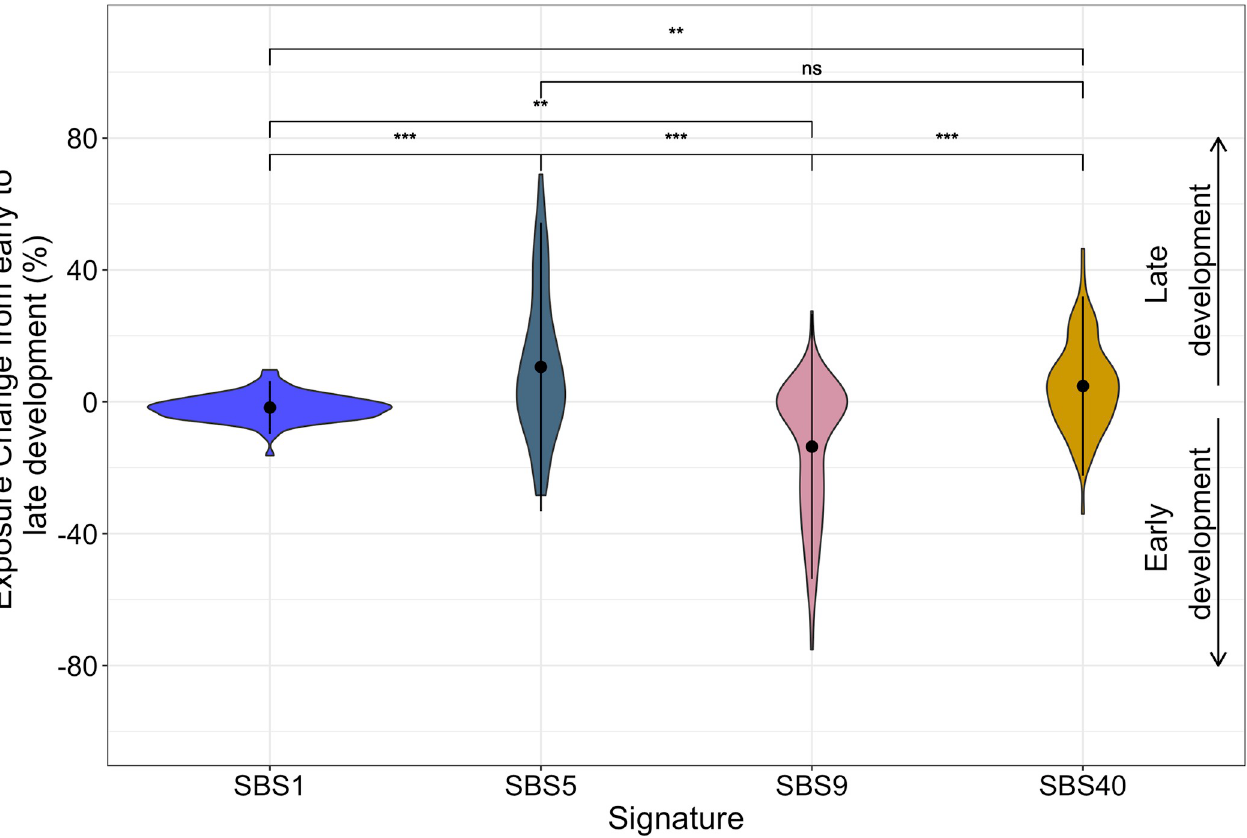
Fig 4. Activity change in four SBS signatures during cancer evolution in 90 Lymph-CLL tumors. Violin plots showing the distribution of signature activity changes (y-axis) from early to late stages of cancer development constructed using TrackSig [7] for 90 chronic lymphocytic leukemia samples. Dot indicates means, vertical line spans +/- one standard deviation. From early to late development, SBS1 changes on average by -1.8% +/- 4.0%, SBS5 by 10.6% +/- 21.9%, SBS9 by -13.6% +/- 20.1%, and SBS40 by 4.7% +/- 13.6%. Brackets display p-values for Kolmogorov-Smirnov tests between activity change distributions, adjusted for multiple comparisons with Bonferroni corrections. � indicates adj. p < 1e-2, �� indicates adj. p < 1e-5, ��� indicates adj. p < 1e-8.